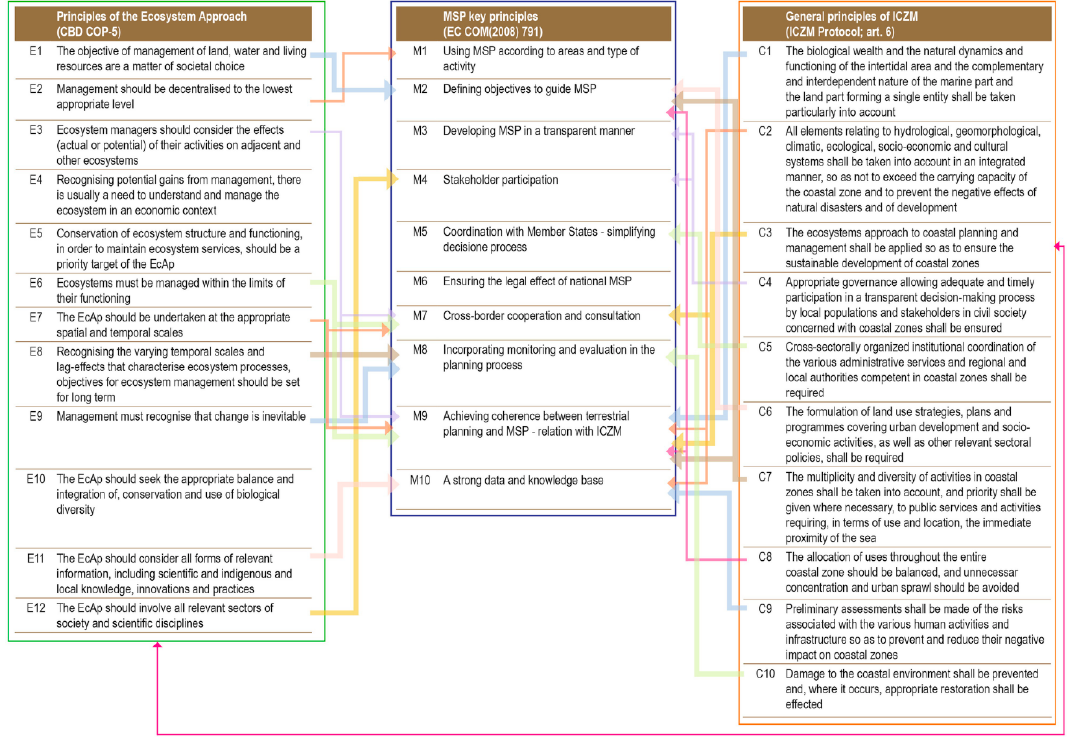
Figure 10. Link between Ecosystem-Based Approach, Maritime Spatial Planning (MSP) and Integrated Coastal Zone Management (ICZM) principles (modified after UNEP-MAP PAP / RAC [146]).